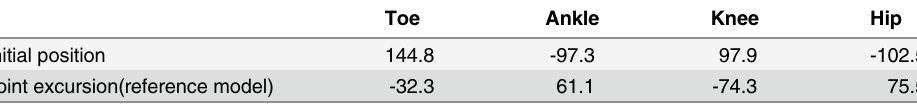
Table 3. Initial conditions. Initial angles and joint excursion of the optimized jump. Angles noted in degrees.